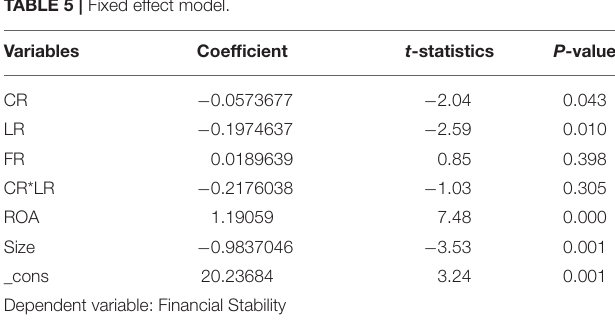
TABLE 5 | Fixed effect model.